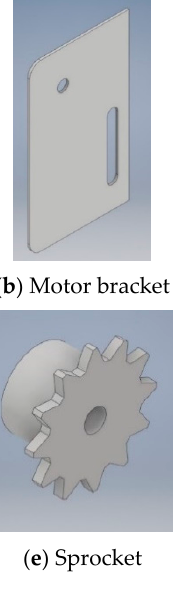
Figure 1. A 3D drawing of the complete assembly and parts.